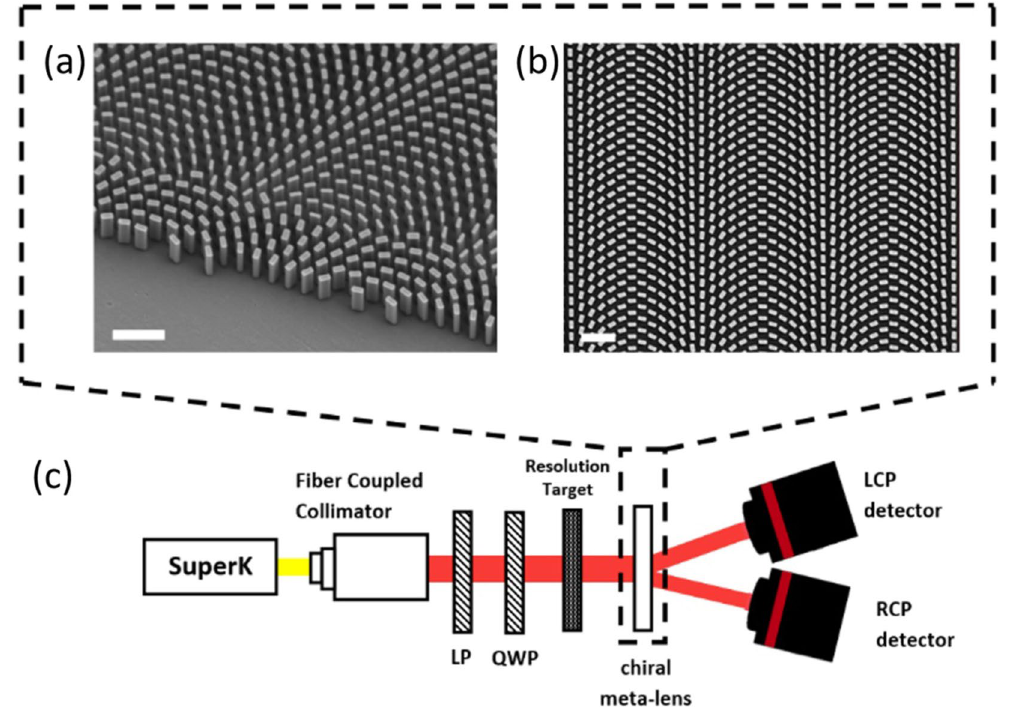
Figure 2. Device and measurement setup. ( a ) Top-side view of the SEM micrograph picture at the edge of the metasurface lens. Scale bar: 1 ( b ) Top-view SEM micrograph picture close to the center of the chiral meta-lens. Scale bar: 1 ( c ) The 1951 USAF resolution test chart illuminated with a supercontinuum laser. The polarization is controlled with a linear polarizer LP and a quarter-wave plate QWP. The sample focuses the LCP and RCP image of the resolution test chart on